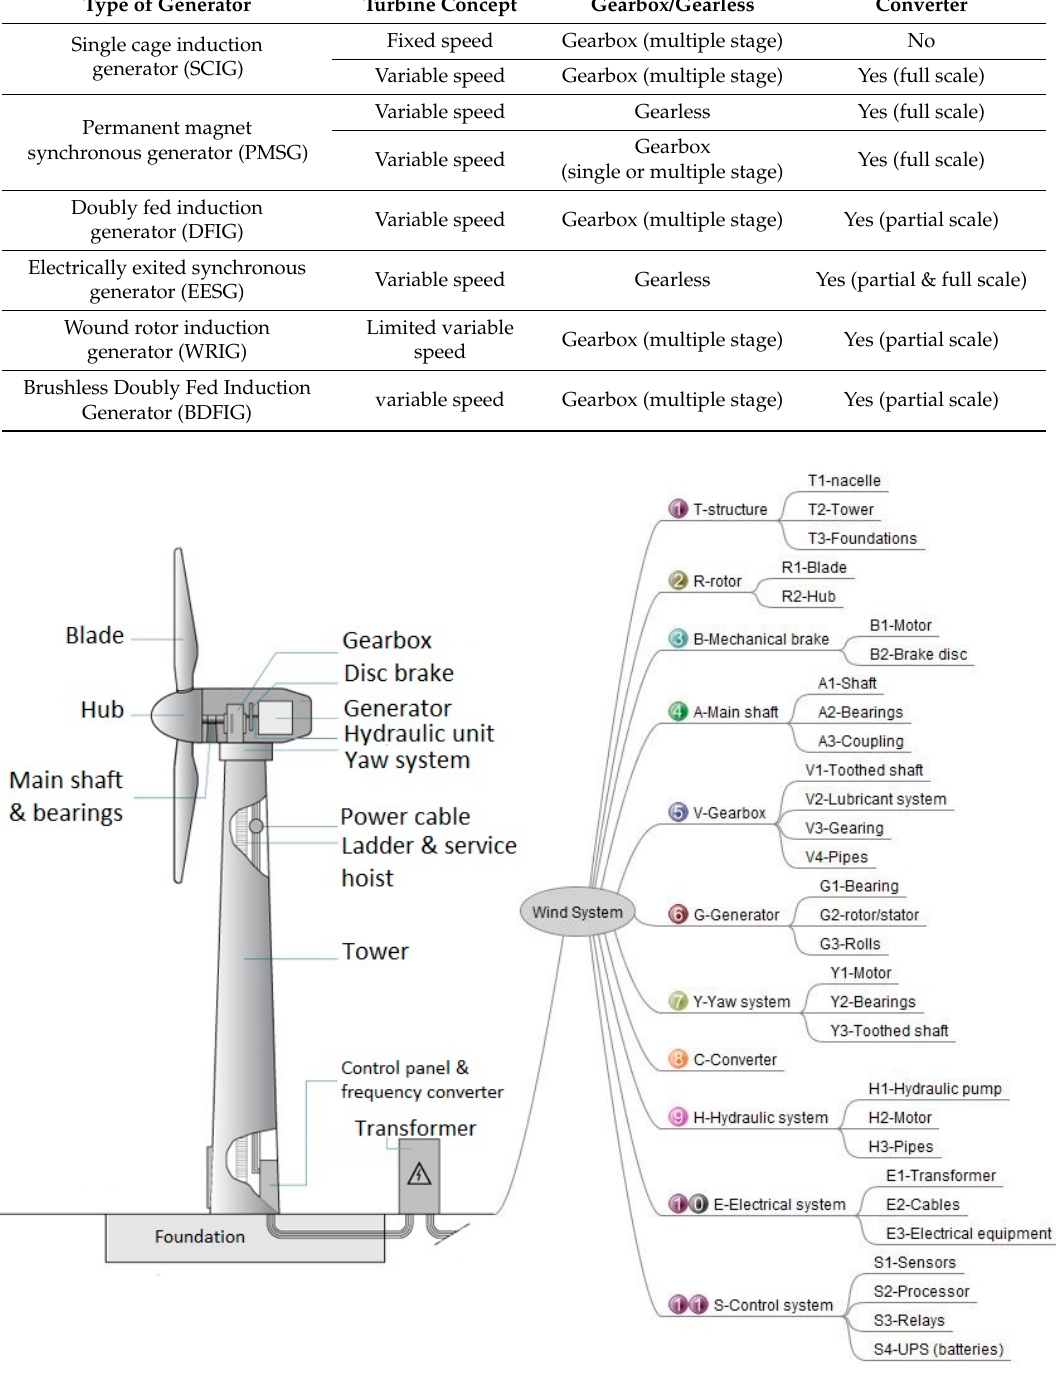
Table 3. Main existing wind turbine systems in European and French Market.